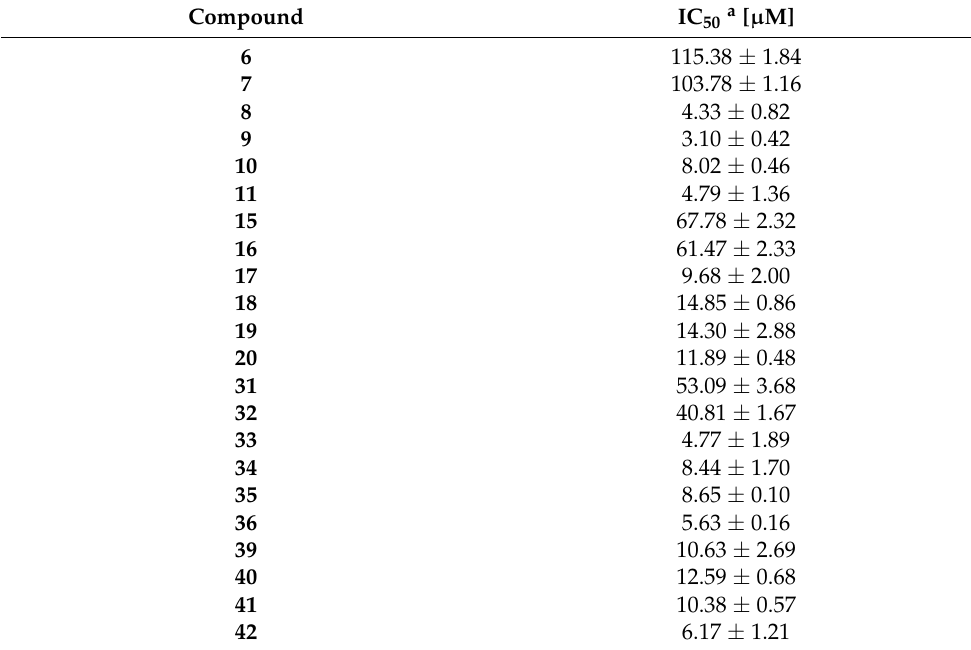
Table 1. Cellular cytotoxic activity of compounds 6 – 11 , 15 – 20 , 31 – 36 , and 39 – 42